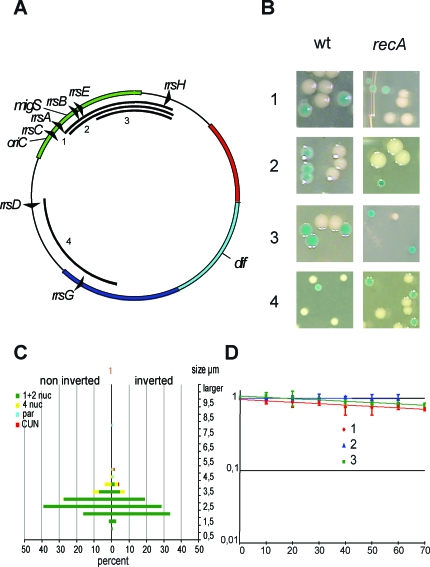
Tolerance to Large Inversions within a Replichore(A) Schematic representation of the E. coli chromosome showing the MDs (Ori in green, Right in red, Left in blue, and Ter in cyan), the seven rrn operons (rrsA to rrsH), replication origin oriC, migS, and dif. The numbered black arcs indicate the position and extent of fragments inverted in the strains 1 to 4 (1: intra O-NSright1; 2: intra O-NSright2; 3: intra O-NSright3; and 4: intra O-NSleft1).(B) Colonies of strains 1 to 4 carrying normal and inverted configurations. Colonies were obtained in a wt or recA genetic background.(C) Comparison of microscopic analyses of cells from strain 1 in wt (noninverted) and inverted configurations as described in Figure 2.(D) Quantification of the growth defects caused by intrareplichore NSright–Ori inversions. Strains 1 to 3 carrying the inverted configuration were grown in serial cocultures with the strain carrying the wt configuration. The ratio of inverted to wt configurations is plotted as a function of the number of generations.